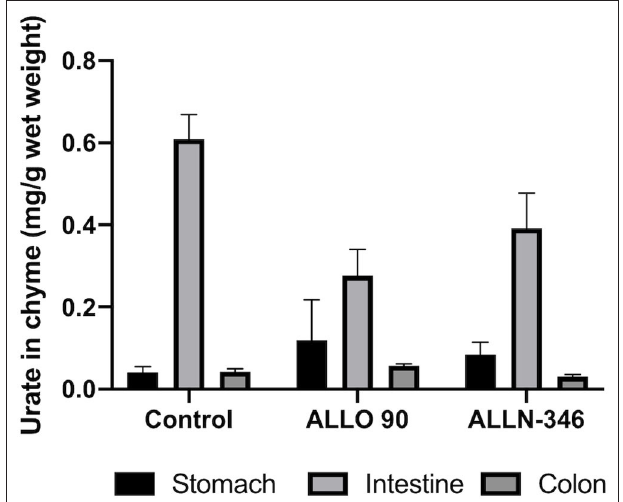
FIGURE 3 | Urate levels in chyme samples from the gastrointestinal tract of uricase/UrOx deficient mice following the 19-day study. Data are shown as mean ± SEM. Control group, no treatment ( n = 7); ALLO 90 group, allopurinol supplemented in drinking water (90 mg/L) ( n = 7); ALLN-346 ( n = 10), ALLN-346 mixed with food and provided for up to